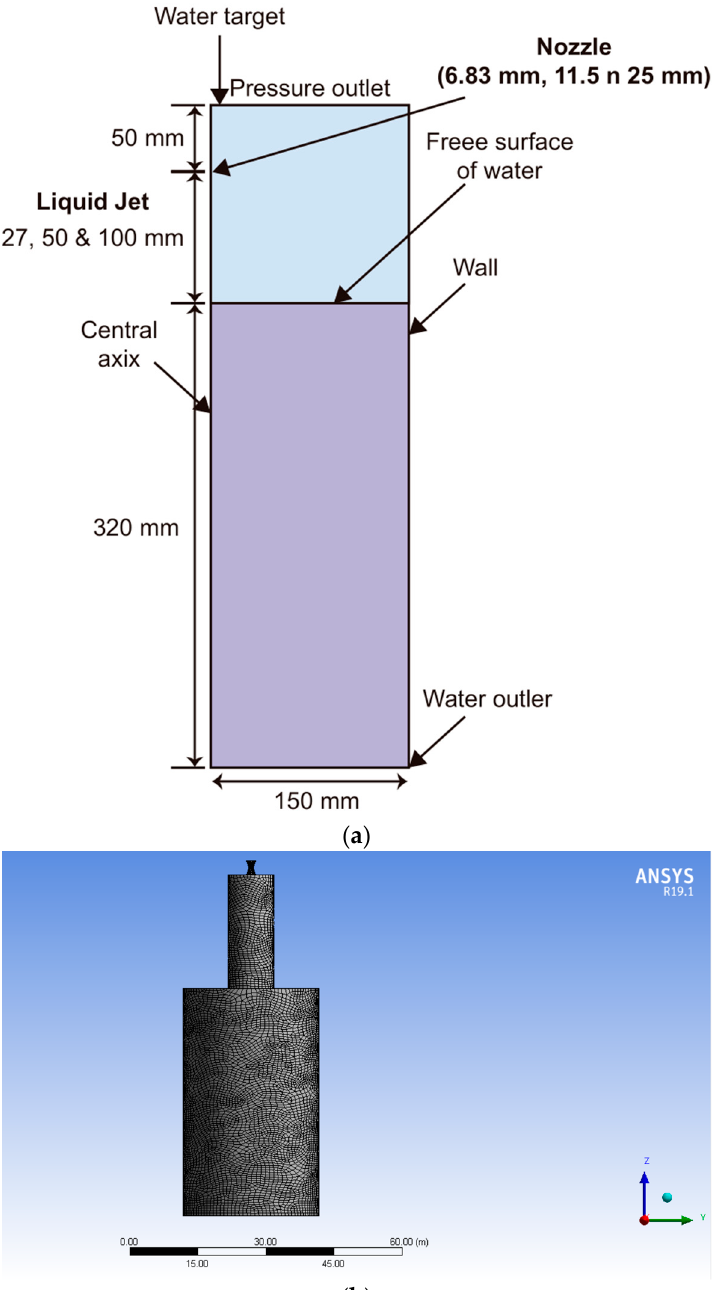
Figure 3. ( a ) Boundary Conditions and Dimensions; ( b ) Simulation Geometry.